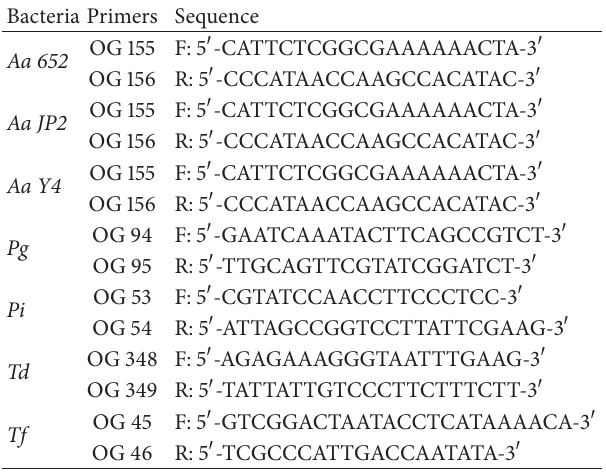
Table 1: Primers used and strains detected by conventional PCR.